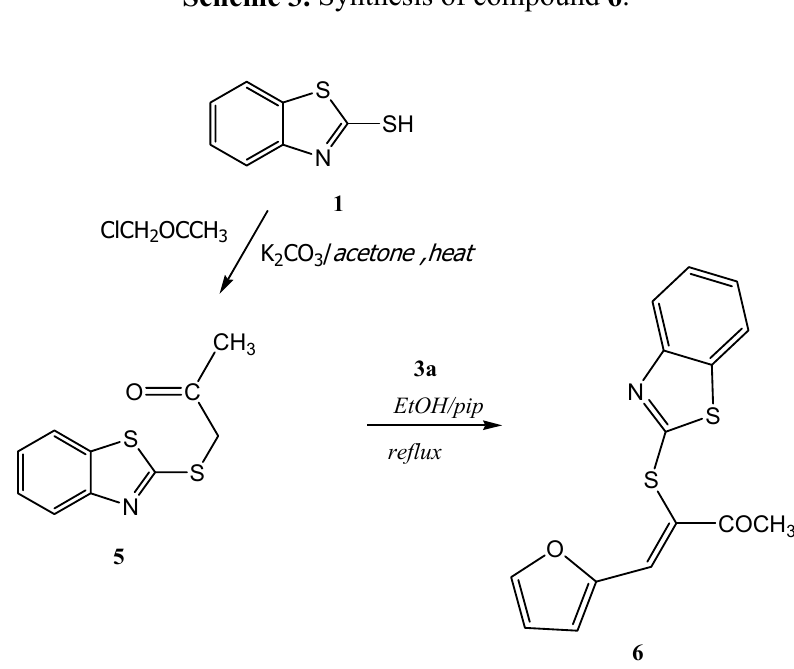
Figure 4. Perspective view and atom labeling of the X-ray structure of 5 .